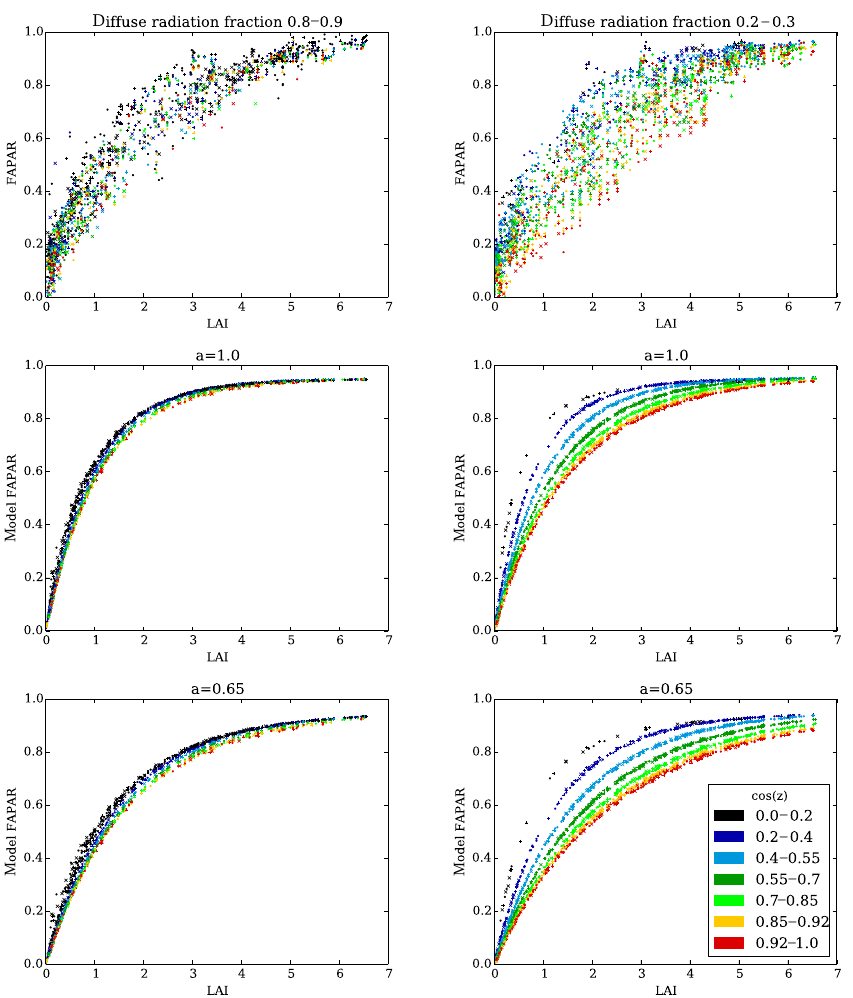
Figure 13. FAPAR against interpolated LAI observations. Top row uses FAPAR observations, while middle row and bottom rows use model FAPAR with a = 1 and a = 0 . 65 respectively, using observed LAI and diffuse radiation fractions. Dots, vertical crosses (+) and diagonal crosses (x) show US-Ne1, US-Ne2 and US-Ne3 respectively and all data are between emergence (DVI = 0) and flowering (DVI = 1). Colours show the cosine of the zenith